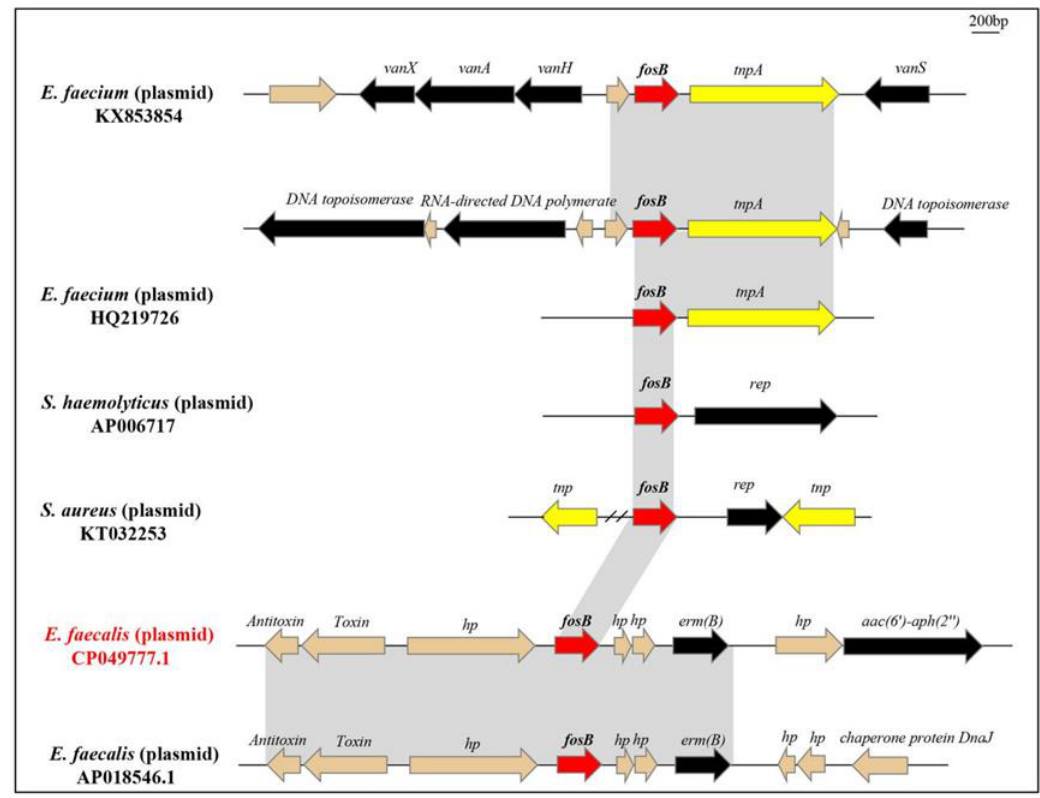
Figure 4. The fosB gene and genetic environment of fosB in different species or genera. fosB genes were indicated by red arrows, and regions of 100% nucleotide sequence identity were shaded in grey. 230